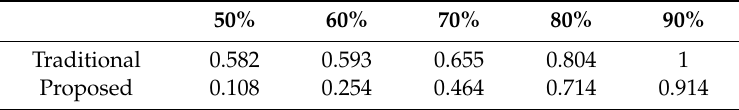
Table 2. Normalized RMSE of attenuation coefficient estimates. 50%